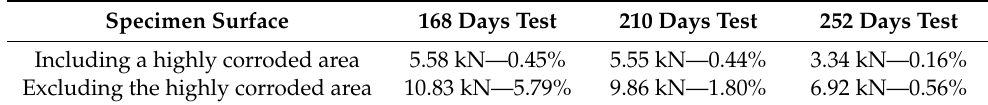
Table 3. UTS—Total deformation of corroded individual wires.